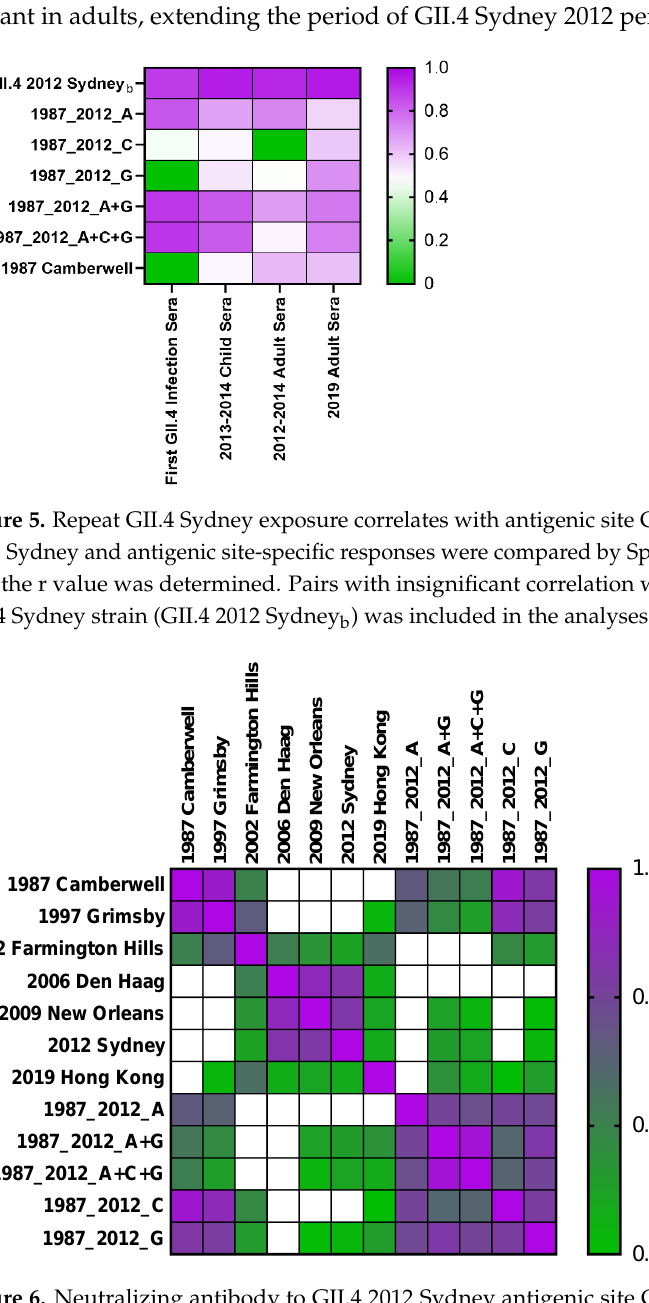
Figure 6. Neutralizing antibody to GII.4 2012 Sydney antigenic site G correlates with nAb to anti- genically distinct GII.4 variants. nAb titers to GII.4 variants and antigenic site chimera VLPs were compared by Spearman correlational analysis, and the r value was determined. All pairings were significant. Pairs with high correlation ( r ≥ 0 .7) are shown.